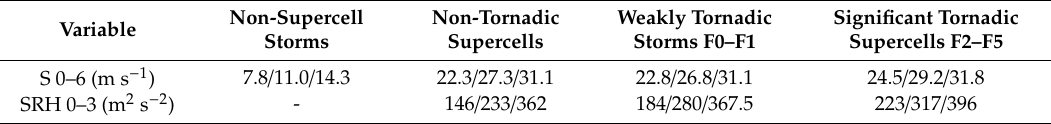
Table 3. Reference values for SRH 0–3 from [28] for di ff erent types of storms. Values in each cell represent median / 75th percentile / 90th percentile. F represents the tornado category according to the Fujita scale.